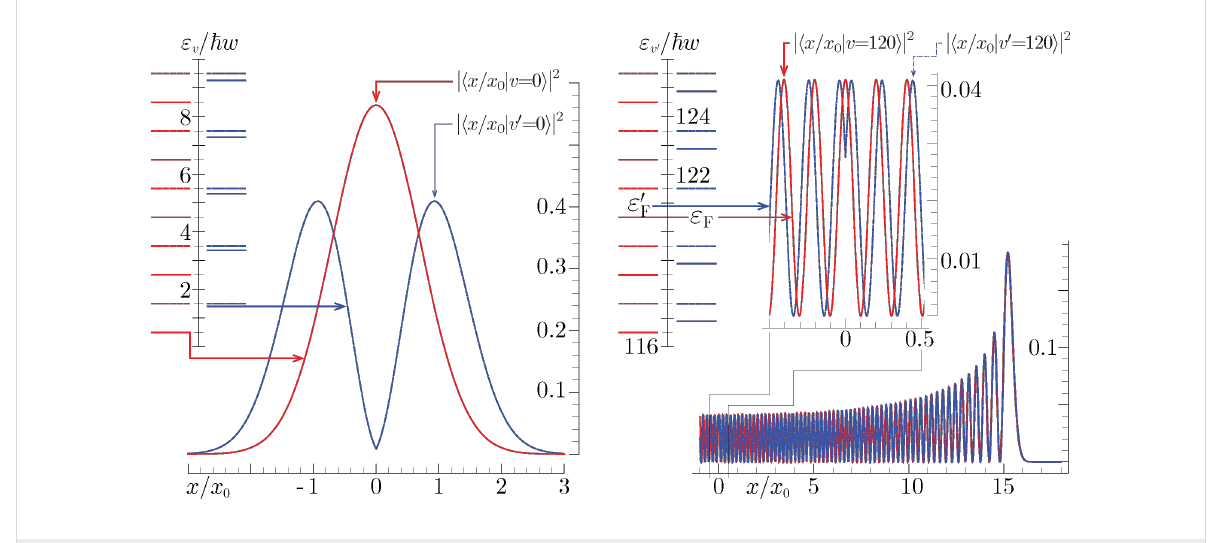
Figure 4: Lowest and highest occupied one-particle wave functions and levels for a harmonically trapped gas of N = 122 fermions in absence and presence of the excited impurity, whose perturbation is characterized by the critical parameter α = 0.1 (see also Figure 3 and Table 2). The unper- turbed and perturbed Fermi levels, relative to the lowest occupied one-particle state, are and , respectively.